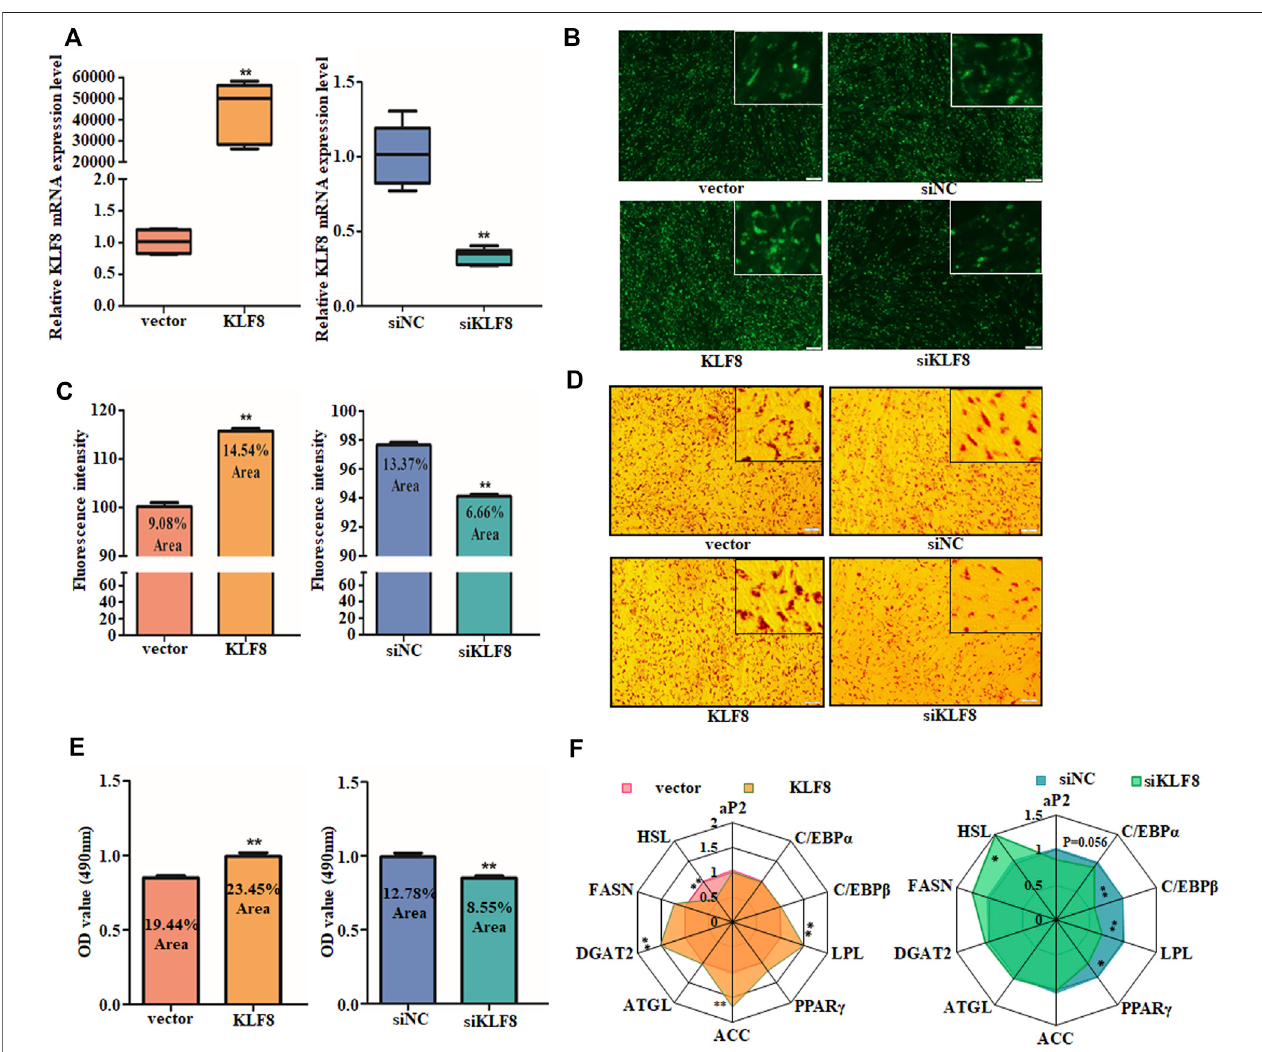
FIGURE5| KLF8promotesGIPCdifferentiation. (A) qRT-PCRanalysisoflevelsofKLF8withKLF8siRNA,expressionplasmid,oreachcontroltransfectedfor24 h. (B) RepresentativeimagesofmatureadipocytesstainedwithBODIPYand (C) stainedareawasmeasuredusingImageJ. (D) RepresentativeimagesofOilRedOstaining of GIPCs with miR-10a-5p inhibitor or control and (E) semi-quantitative assessment of Oil Red O content absorbance detection at 490 nm. (F) qRT-PCR analysis of genes expression in GIPCs with KLF8 up- or downregulation, the result was showed by a network diagram. N > or (cid:1) 3 for B and D, * indicates p values < 0.05 and ≥ 0.01, ** indicates p values <